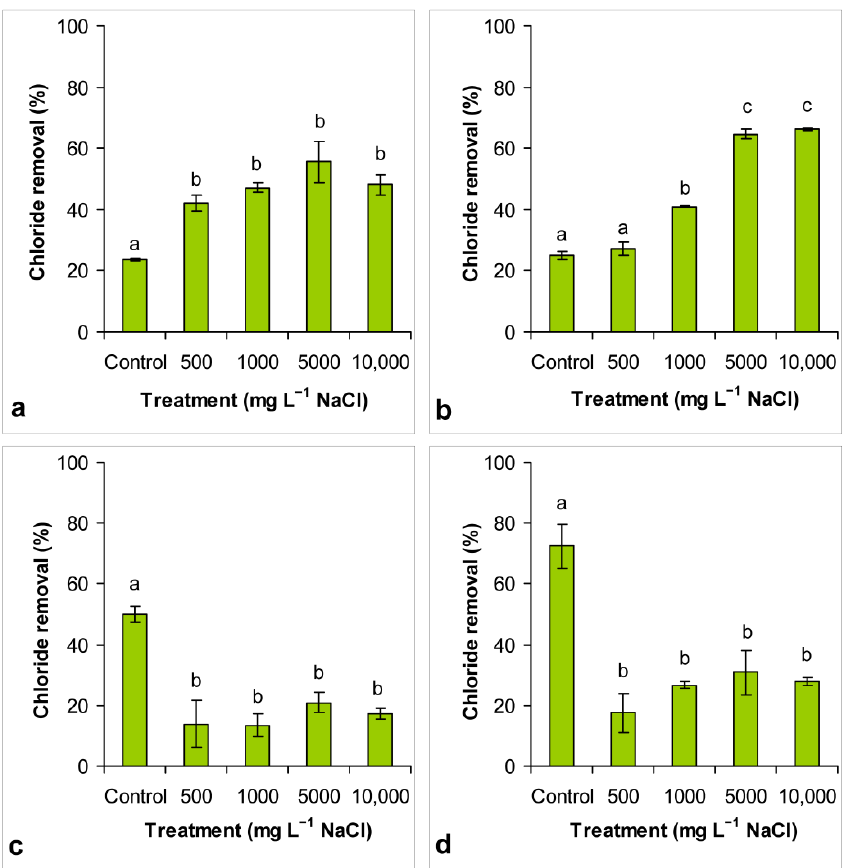
Figure 5. Chloride removal (%) of control and NaCl-treated Coelastrum morus cultures in: ( a ) HC-LR; ( b ) HC-HR; ( c ) LC-HR and ( d ) LC-LR media. HC: higher content; LC: lower content; HR: higher ratio; LR: lower ratio. Mean values ( n = 3) and standard deviations are plotted. Significant differences ( p < 0.05) are indicated by different lowercase letters.